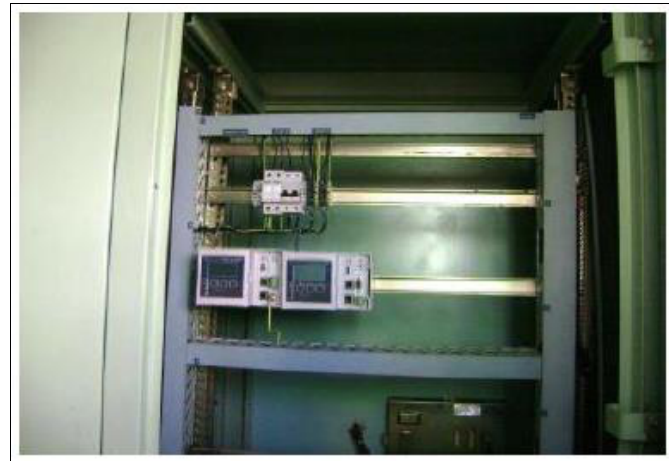
Figura 3: TankScanner NXA820 instalados en el campo. Fuente: Los Autores, (2015).